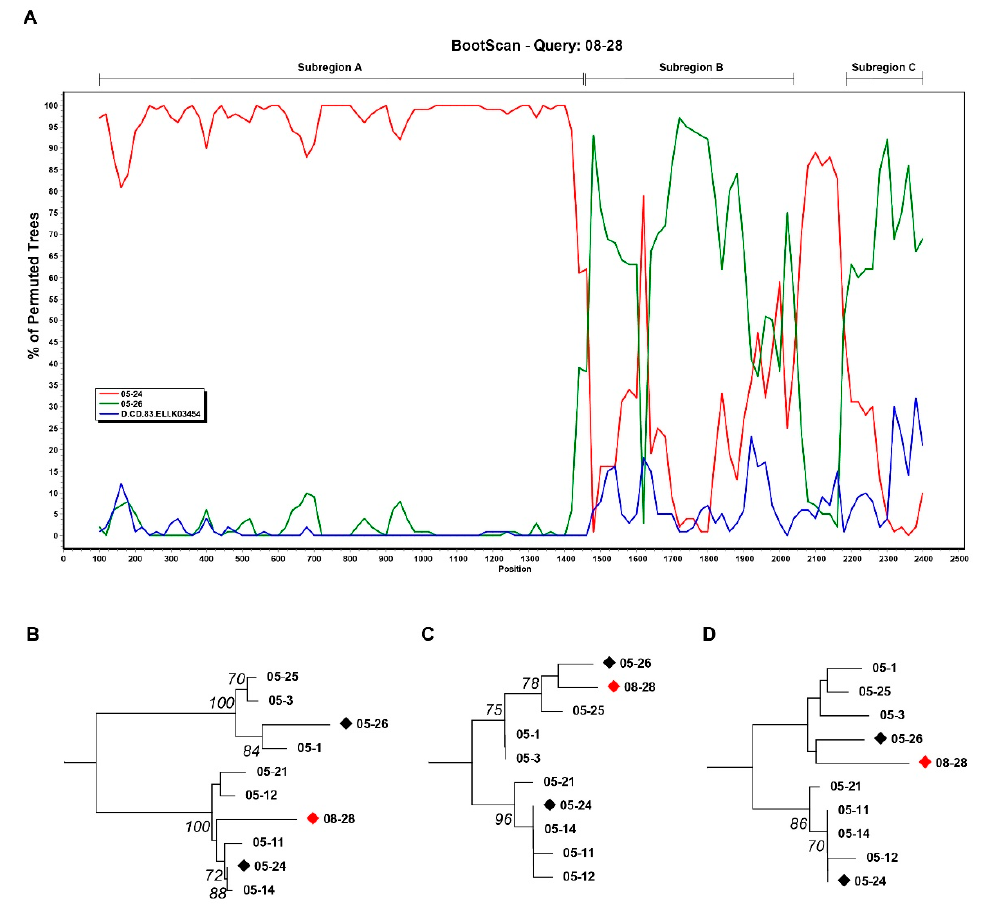
Figure 2. Recombination analysis. ( A ) The similarity between 08-28 and the reference sequence (05-24, 05-26, and D.CD.83ELI.K03454) was plotted using Simplot 3.5.1 software. The x-axis is the nucleotide position in the HIV-1 envelope genomic sequence. The y-axis shows the percentage supporting the clustering with different reference sequences. Subregion A, Subregion B, and Subregion C were indicated. ( B ) The neighbor-joining tree of Subregion A. Sequence 08-28 (nt 6427~7812) clustered with lineage b. ( C ) The neighbor-joining tree of Subregion B. Sequence 08-28 (nt 7816~8282) clustered with lineage c. ( D ) The neighbor-joining tree of Subregion C. Sequence 08-28 (nt 8333~8595) clustered with lineage c.